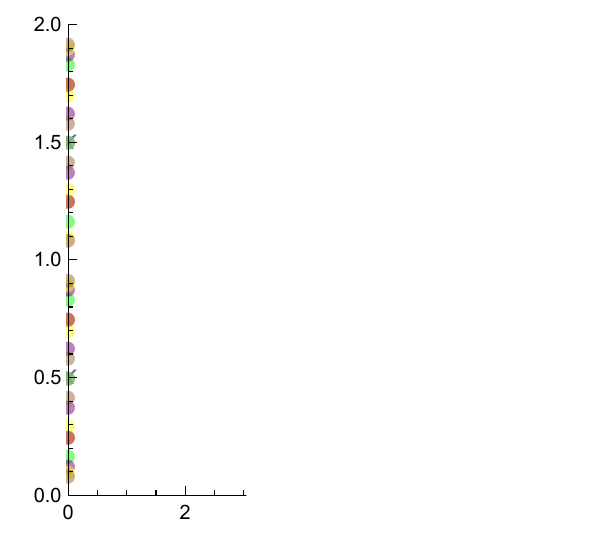
Figure 6 . The projection on the vertical axis of the exponents represented in (cid:12)gure 5 (cid:12)eld theory at c < 1, and thus admit analytical expressions [51, 52]. In particular,